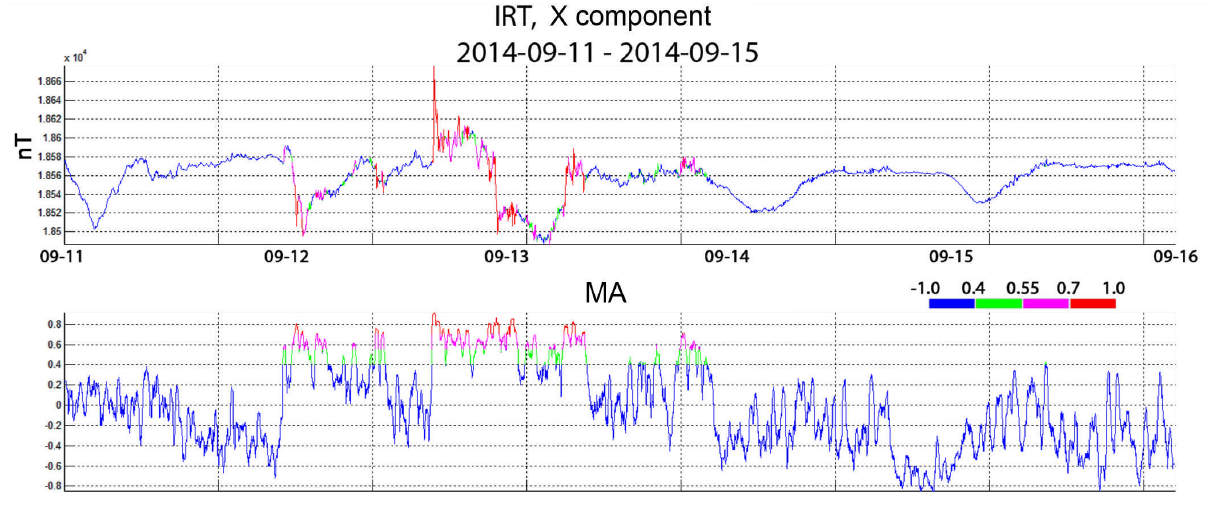
Figure 6. Estimation of geomagnetic activity using X component record, obtained at Irkutsk observatory on September 11-15, 2014 (upper plot) using MA (lower plot). In the both plots background values ( µ ( t )<0.4) are marked with blue, weakly anomalous values ( µ ( t ) ∈ [0.4,0.55)) are marked with green, anomalous values ( µ ( t ) ∈ [0.55,0.7)) are marked with purple and strongly anomalous values ( µ ( t ) ≥ 0.7) are marked with